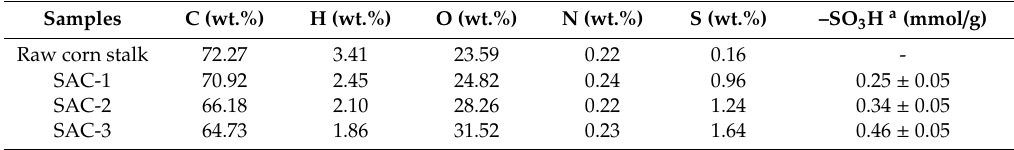
Table 3. Elemental analysis of biochar-based solid acid